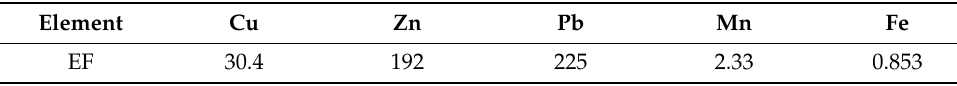
Table 3. EF for the elements in PM 10